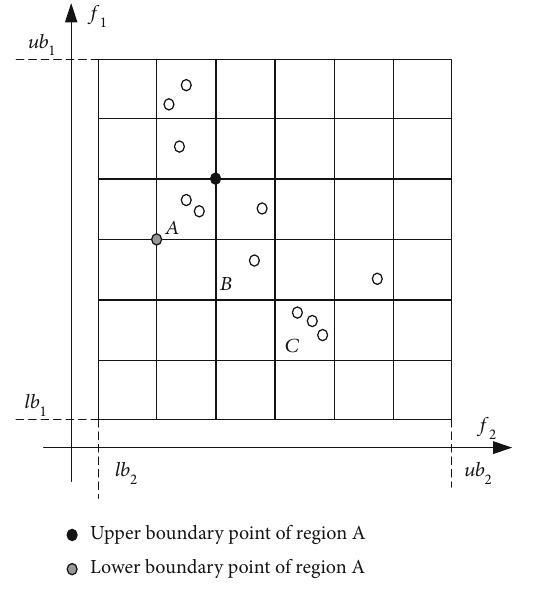
Figure 3: Grid and its